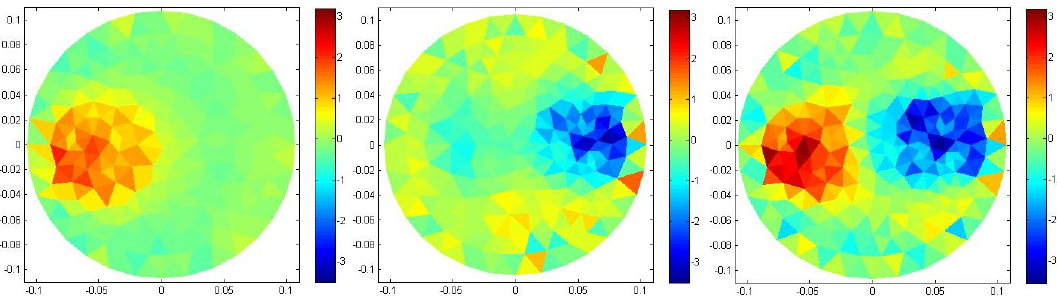
Figure 10: Reconstruction image of the relative method in non-uniform elements